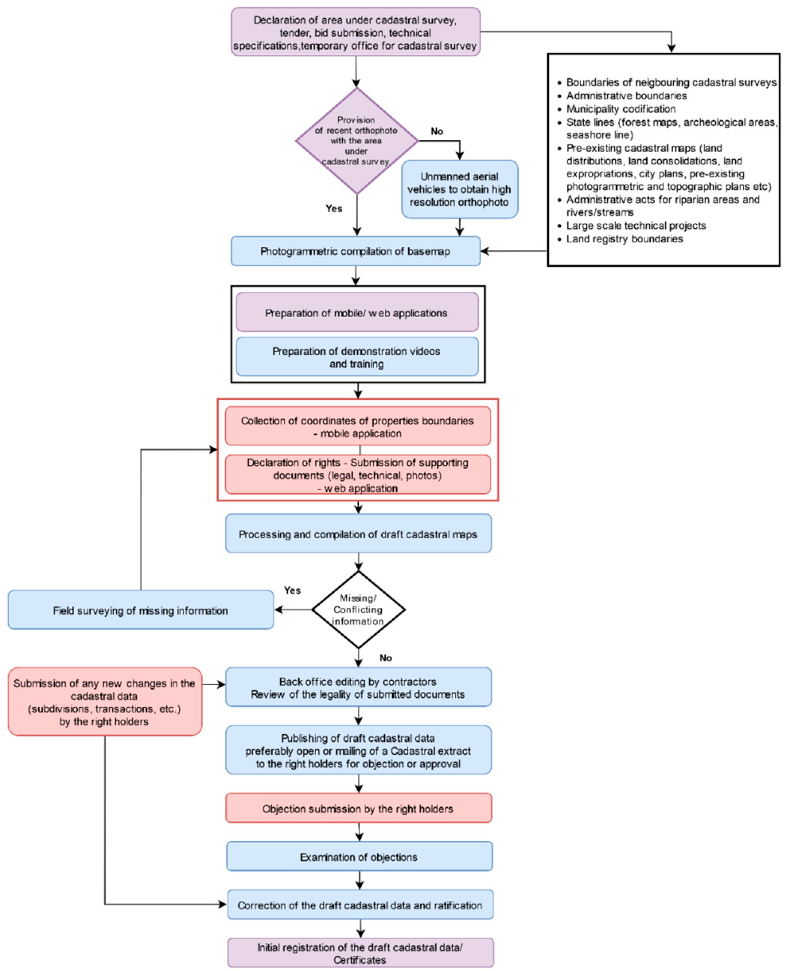
Figure 1. The proposed crowdsourced procedure: NMCA’s actions (purple); contractors’ actions (blue); right holders’ actions (pink).